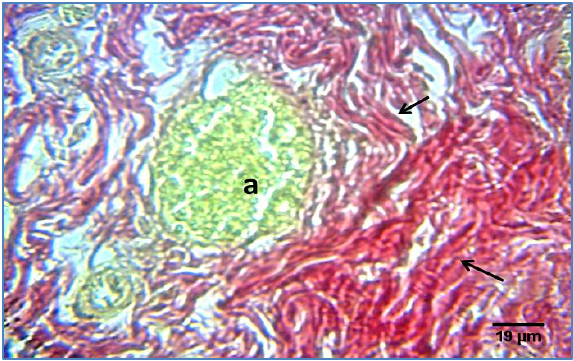
Figure, 6: Shows congested blood vessels (a). Irregular collagen bundles (Arrows). (grade, 3) (Van Gieson’sstain), 30thday post-operation, in group A.